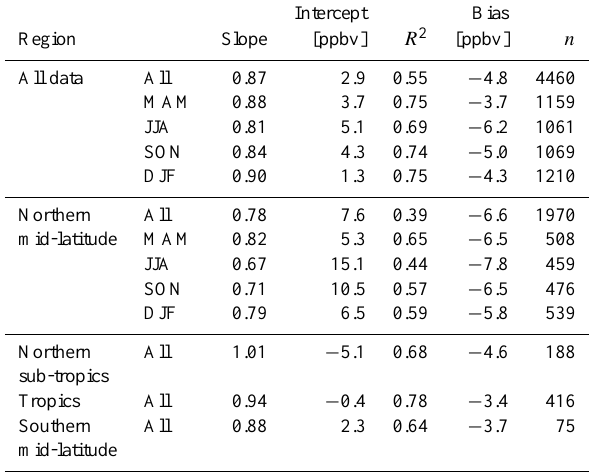
Table 2. Slope and intercept of a (unweighted) linear regression fit to the seasonal mean TES–sonde O 3 biases per latitude zone at the 464hPa pressure level for the period 2005–2010. The standard er- ror (SE) is also given for the slope (ppbv/season) and the intercept (ppbv). The mean annual bias (ppbv) is also shown. The statistical procedure testing if the intercept of the linear relation is signifi- cantly different from zero is given by the p values (rejection of null hypothesis at p < 0.05).